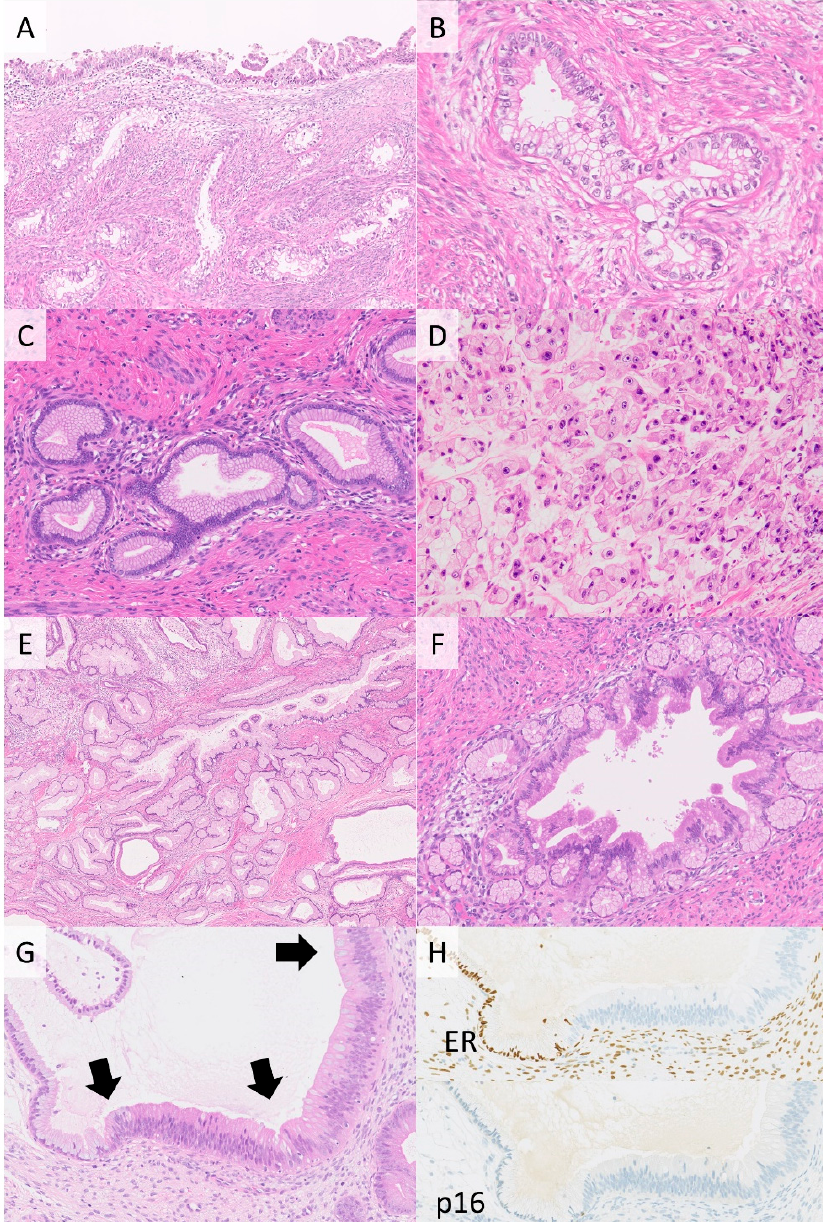
Figure 3. Gastric-type adenocarcinoma (GAS) of the cervix. GAS is a representative histological type of HPV-independent cervical cancers. Irregular glands ( A ) are composed of tumor cells with clear to pale eosinophilic cytoplasm and enlarged nuclei ( B ). GAS shows histological heterogeneity: very well-differentiated adenocarcinoma so-called “adenoma malignum”( C ) whereas poorly differentiated adenocarcinoma ( D ). Some GASs have adjacent lobular endocervical glandular hyperplasia (LEGH) ( E ) and atypical LEGH is postulated as one of the pre-invasive lesions of GAS ( F ). Gastric-type adenocarcinoma in situ (( G ), black arrows) shows negativity of immunohistochemistry for estrogen receptor and p16 ( H ). (( A , E ) H & E stain, ×100; ( B – D , F , G ), H & E stain, ×200; ( H ) ×200). Microscopically, gastric differentiation is described as tumor cells with distinct cell borders and voluminous clear to pale eosinophilic cytoplasm (Figure 3) [91] and may re- semble adenocarcinoma cells of gastric and pancreatobiliary origin. Morphological intra- tumor heterogeneity is a well-recognized feature of GAS, with the same tumor having well-differentiated, minimally deviated adenocarcinoma (MDA)-like components adja- cent to poorly differentiated carcinoma. GAS cells contain acidic mucin and express sim- ilar immunomarkers to gastric mucus cells, such as HIK1083, lysozyme, and pepsinogen